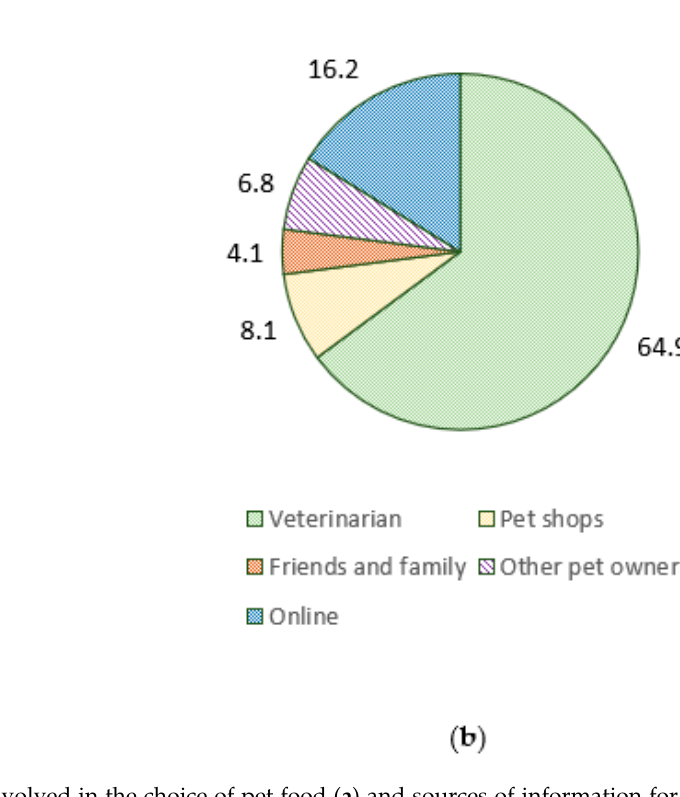
Figure 3. Major factors involved in the choice of pet food ( a ) and sources of information for this choice ( b ).